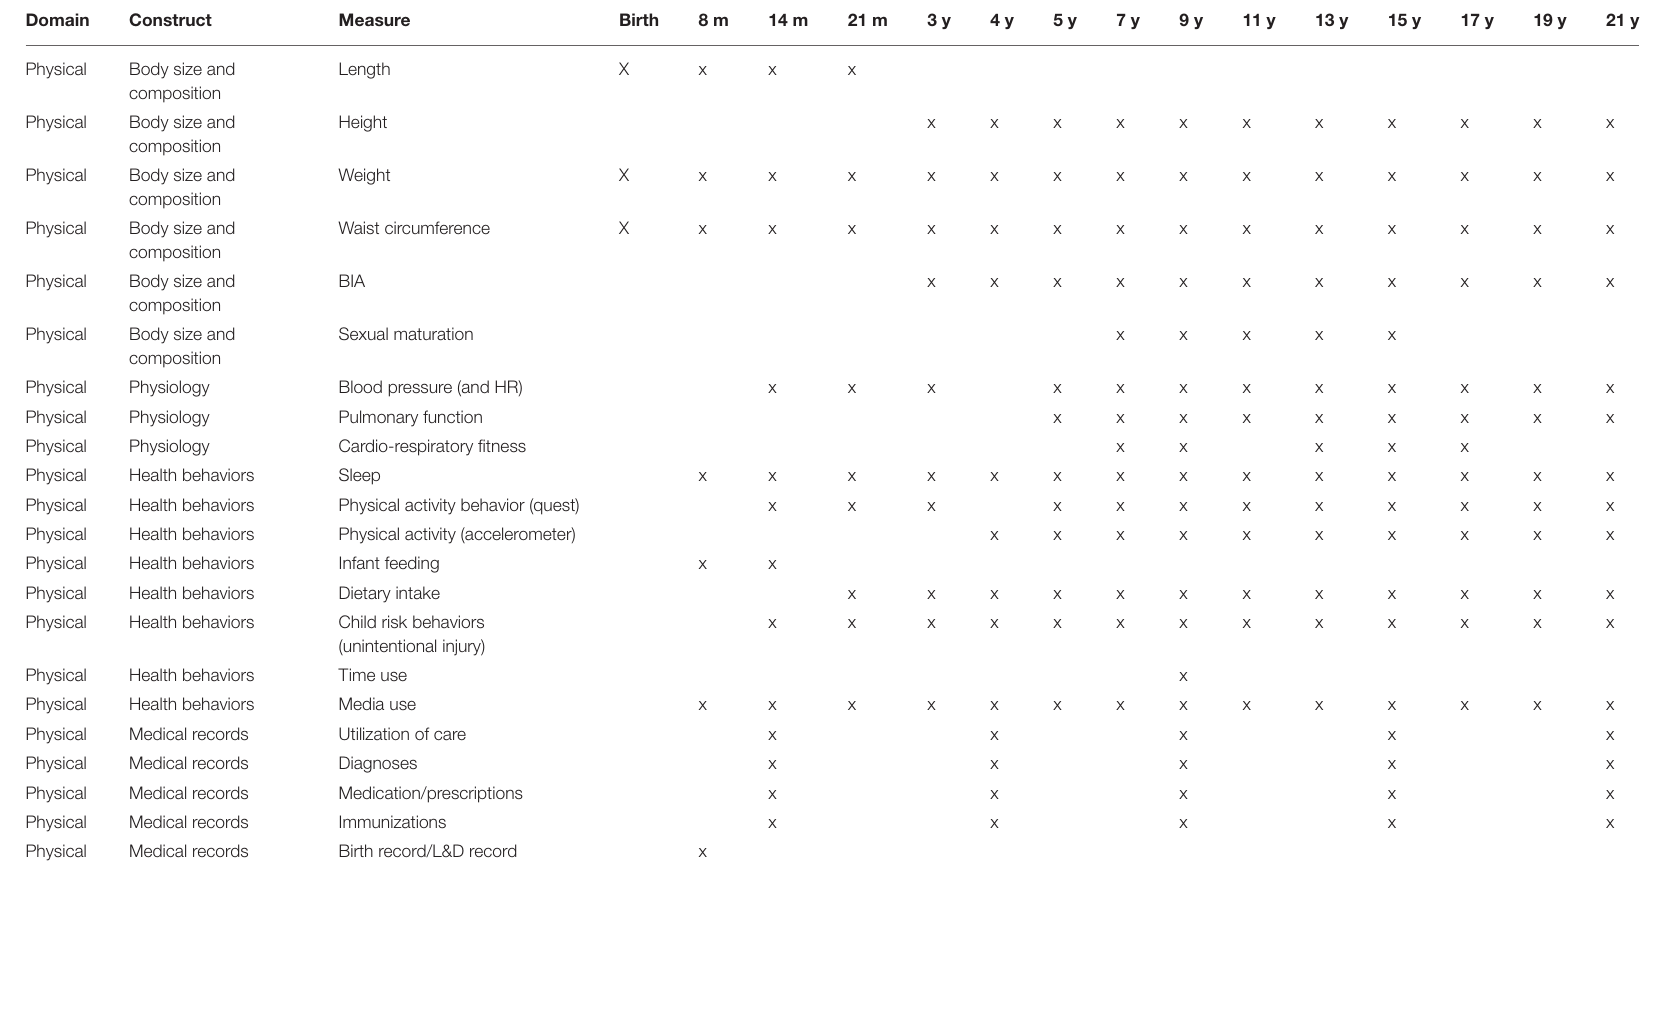
TABLE 3 | Physical health